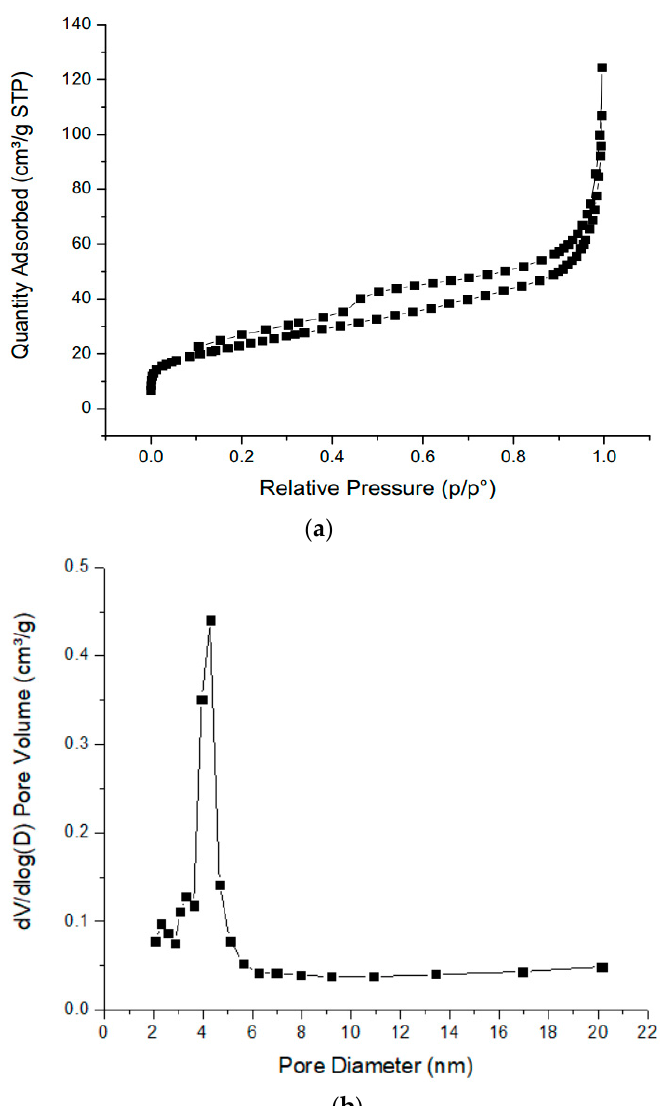
Figure 3. ( a ) N 2 adsorption–desorption isotherm of (3%)Ag-TiO 2 /rGO/HNT. ( b ) Pore size distribu- tion of (3%)Ag-TiO 2 /rGO/HNT.